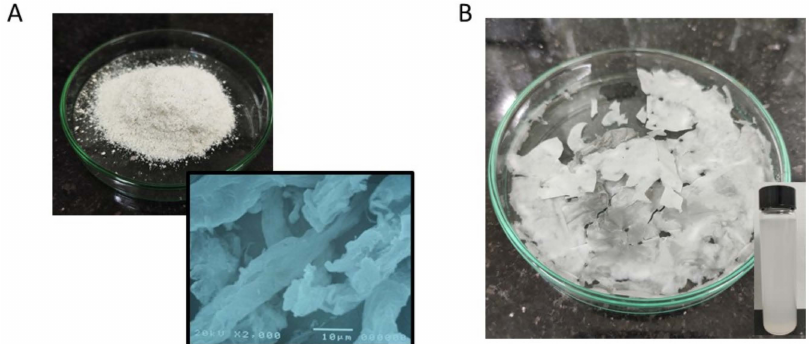
Figure 2. ( A ) Image of bleached DFF with scanning electron microscopy (SEM) images. ( B ) Image of dried cellulose nanomaterials, CNs, obtained after the freeze-drying process with an inset showing the dispersion of CNs in water after 7